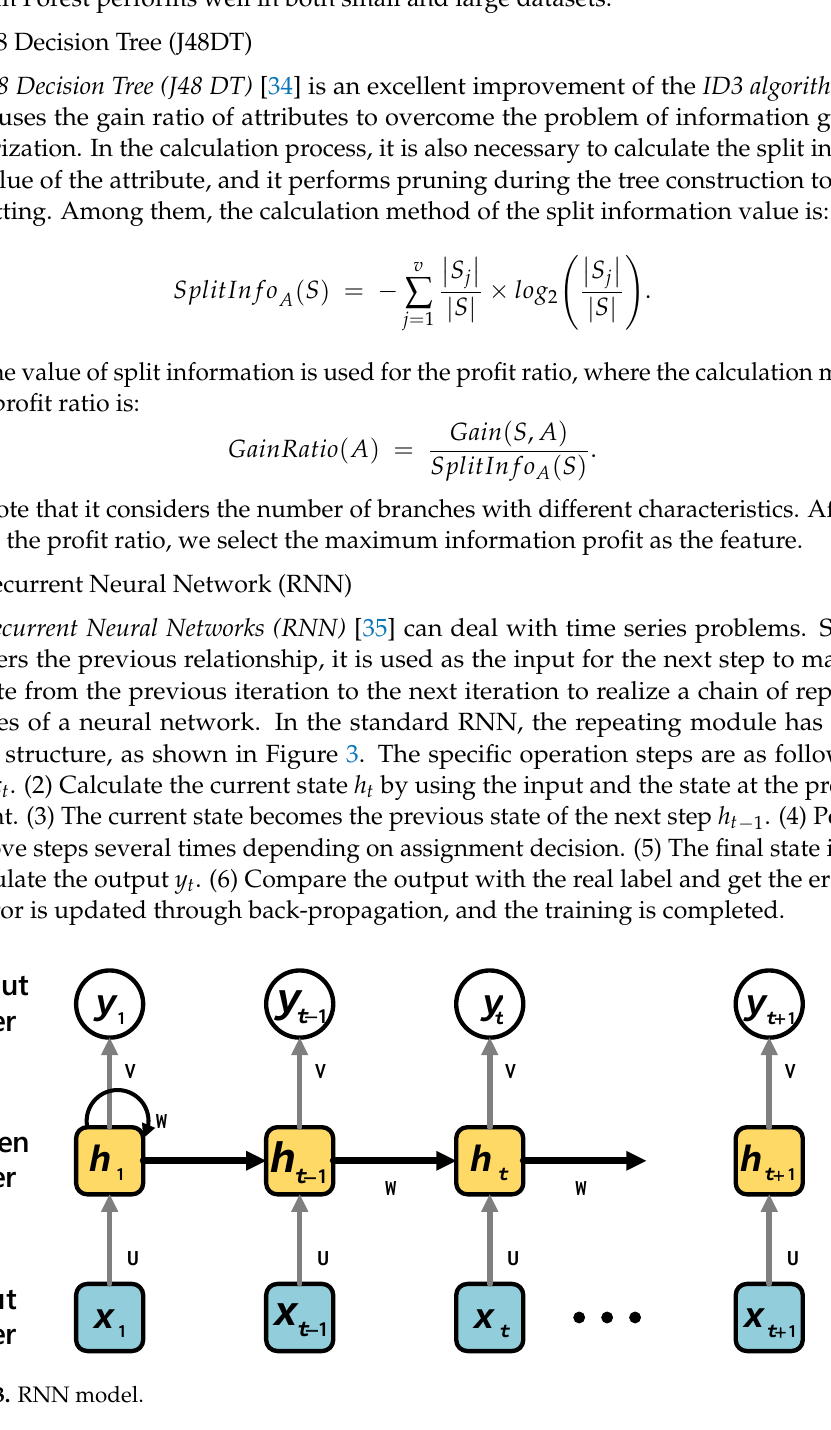
t h t c 1  t x Output Forget Input Figure 4. LSTM structure.